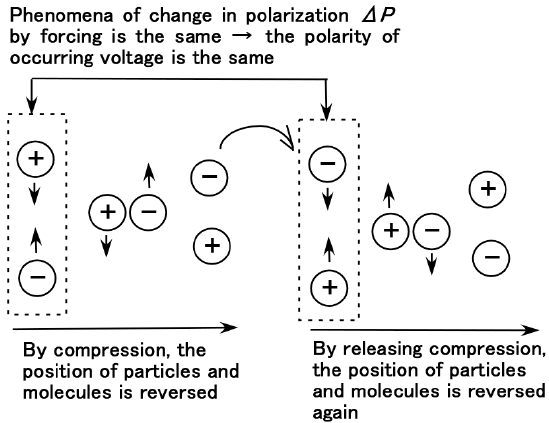
Figure A1. Schematic diagram of change in configuration of ionized particles and molecules at the part of MCF rubber by compression and release.